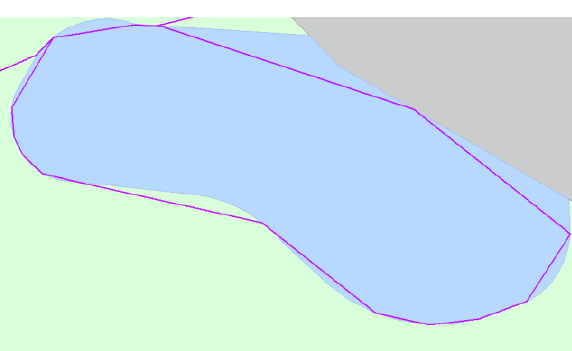
Figure 13. Adjustment result for pond area (test case 3)